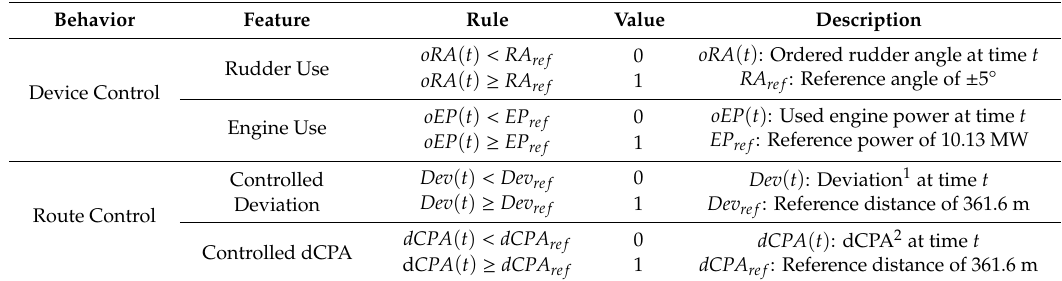
Table 6. Rules for the detection of four maneuvering behavior